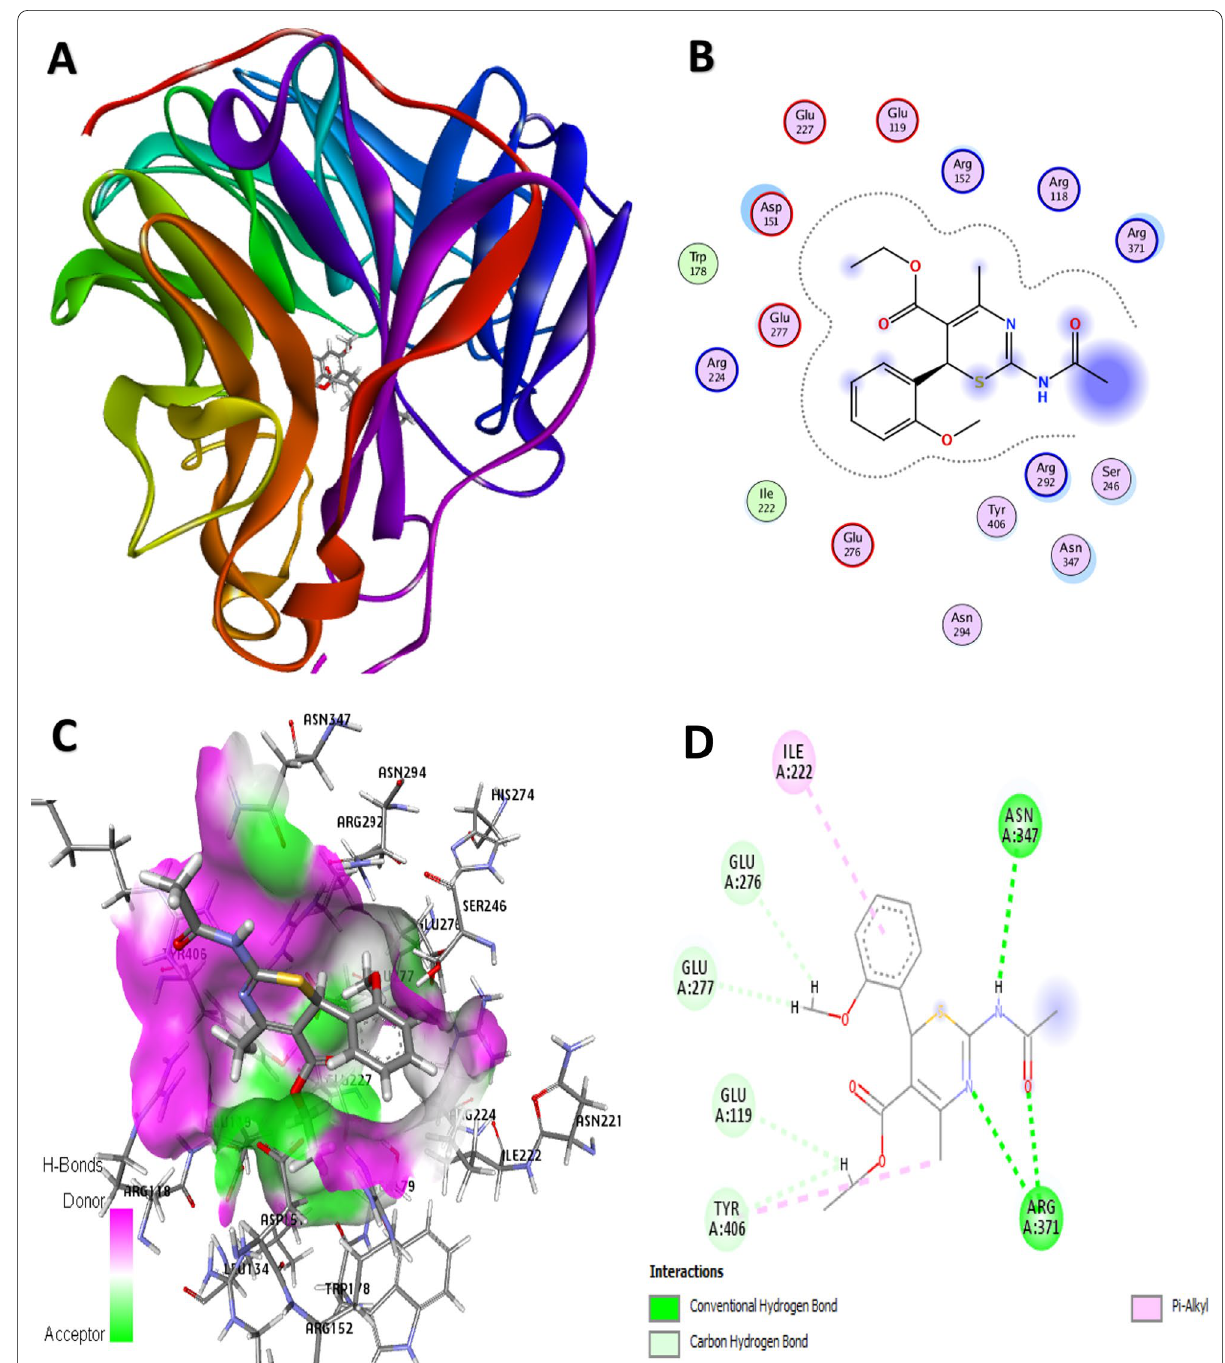
Fig. 10 3D docking view of compound 4 with the H1N1 neuraminidase receptor (PDB: 3TI6). A The best pose of compound 4, B residual interaction of compound 4-complex, C 3D hydrogen bond surfaces around the ligand, D 2D residual interaction of